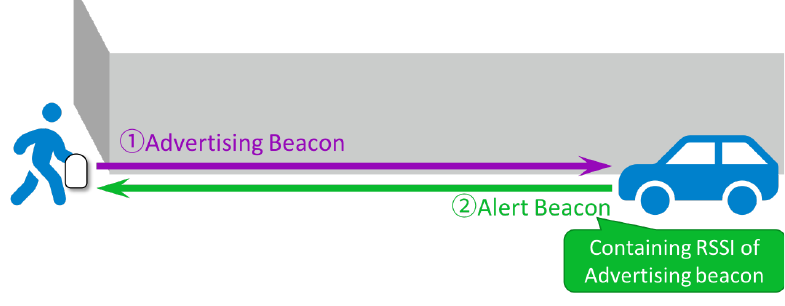
Figure 3. The proposed ND-based